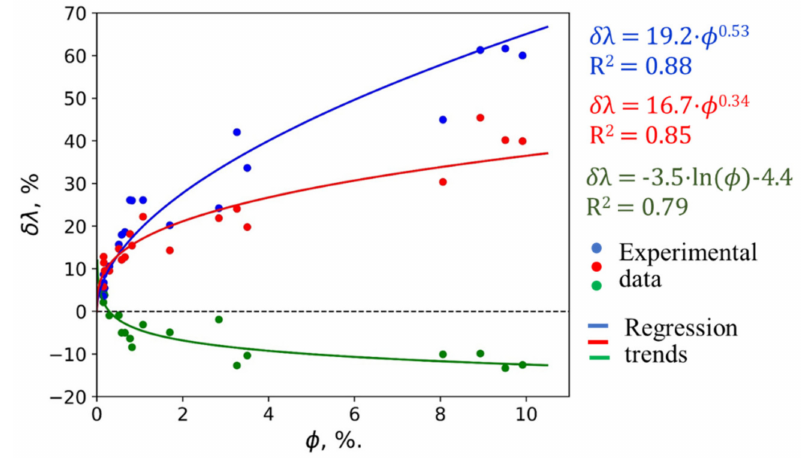
Figure 9. The dependence of thermal conductivity variations on porosity of core samples after drying (green line) and after water saturation under vacuum (blue line). The red line shows the thermal conductivity change from “as received” state to